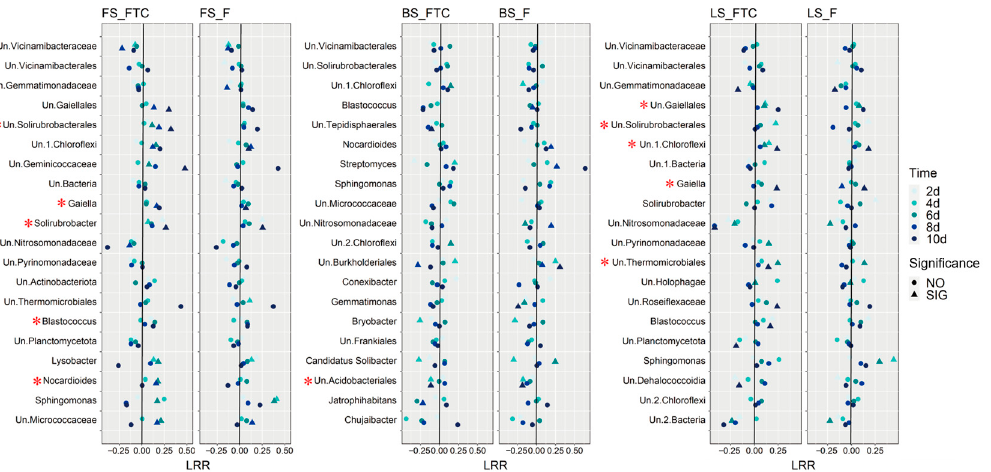
Figure 5. The dot plots show the log response ratio (LRR) of the top 20 genera with the highest relative abundance in the FTC or F treatments compared with the CK treatment at five incubation times in fluvo-aquic soil, black soil and loess soil; “SIG” and “NO” indicate significant and non-significant differences in the relative abundance between the FTC or F and CK treatment at the same incubation time; * indicates a positive Pearson correlation between the denitrification potential and the relative abundance of the genera in the FTC, F and CK treatments at the five incubation times. CK: control treatment (10 °C); F: freezing treatment ( − 10 °C); FTC: freeze–thaw cycles ( − 10/10 °C); Un: unidentified taxa.